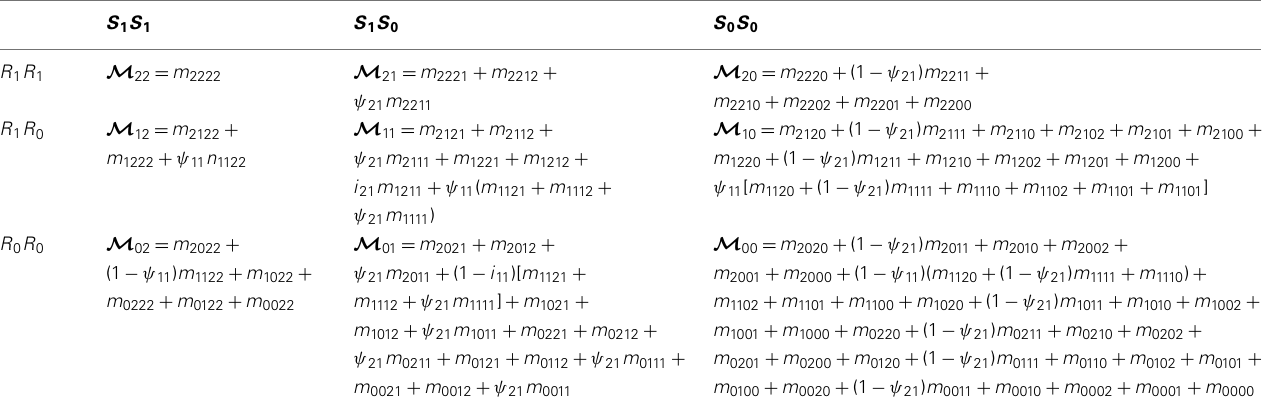
TableA1 | Frequencies of across-block composite diplotypes calculated from across-block genotypes in cases, assuming that AB is the risk haplotype for block 1 and CD is the risk haplotype for block 2.